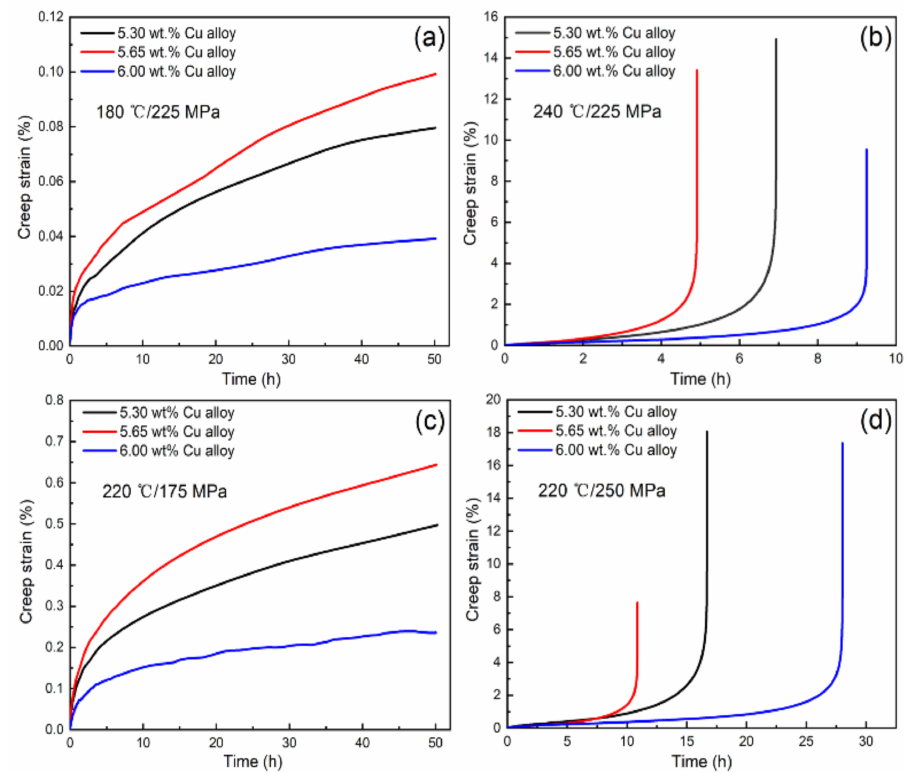
Figure 1. CreepcurvesofthreeAl–Cu–Mg–Agalloysunderdifferentcreepconditions: ( a ) 180 ◦ C/225 MPa, ( b ) 240 ◦ C/225 MPa, ( c ) 220 ◦ C/175 MPa, and ( d ) 220 ◦ C/250